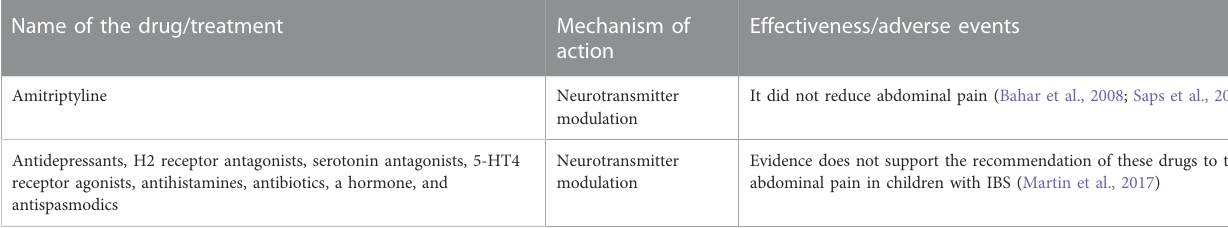
TABLE 3 Conventional and complementary treatments of IBS in